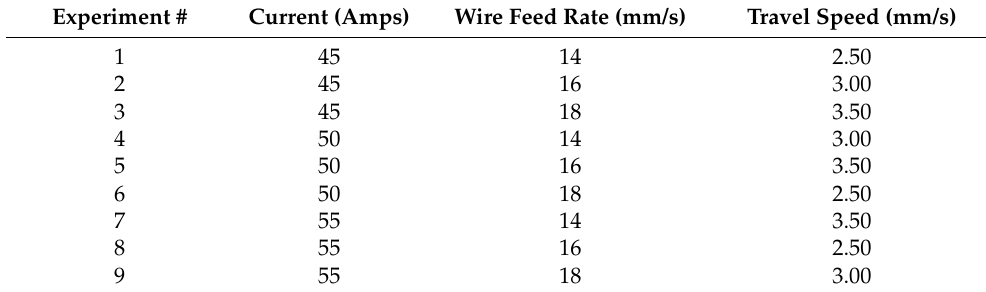
Table 2. Design of experiments parameters and values for deposition of the plain carbon steel alloy.